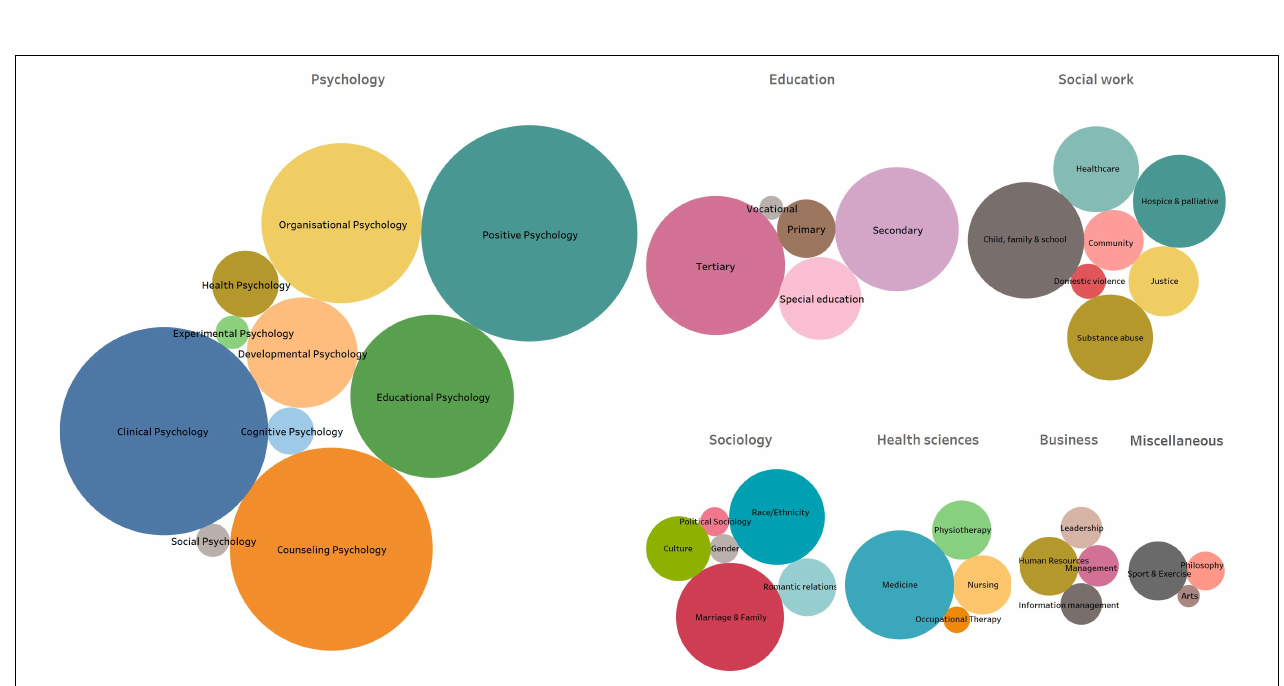
FIGURE 2 | Constellation map showing clusters of application of hope research across